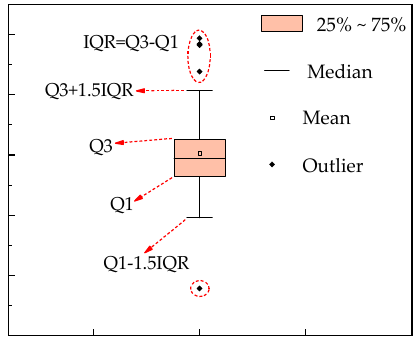
Figure 6. Box diagram structure.